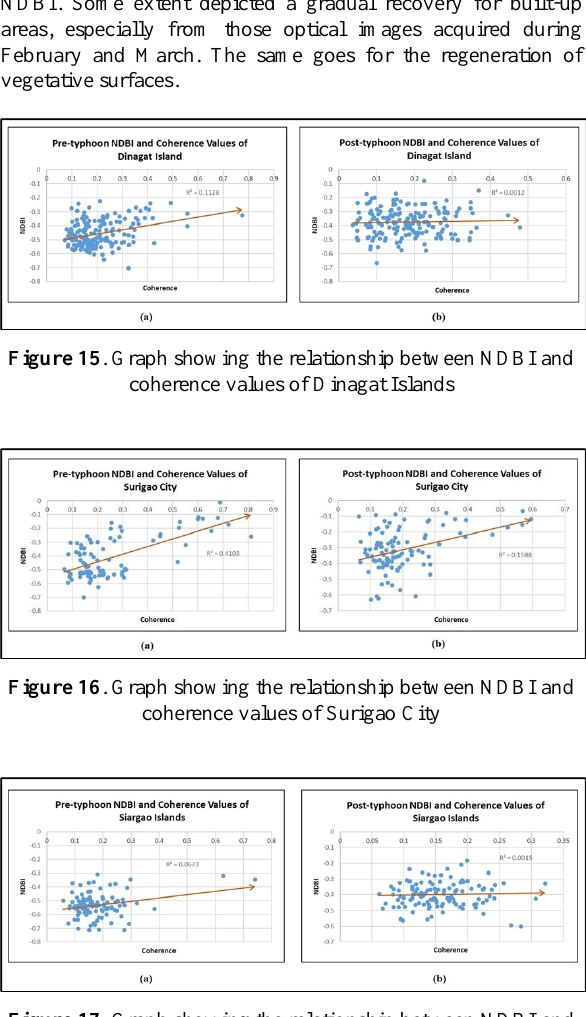
Figure 17 . Graph showing the relationship between NDBI and coherence values of Siargao Islands